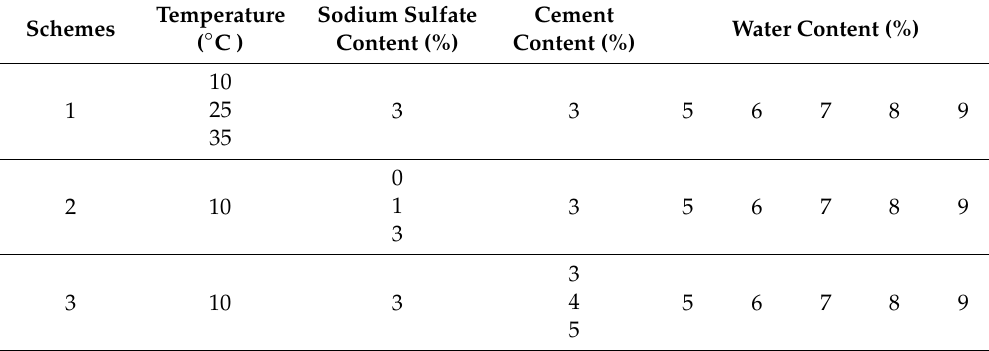
Table 6. The specific scheme of the